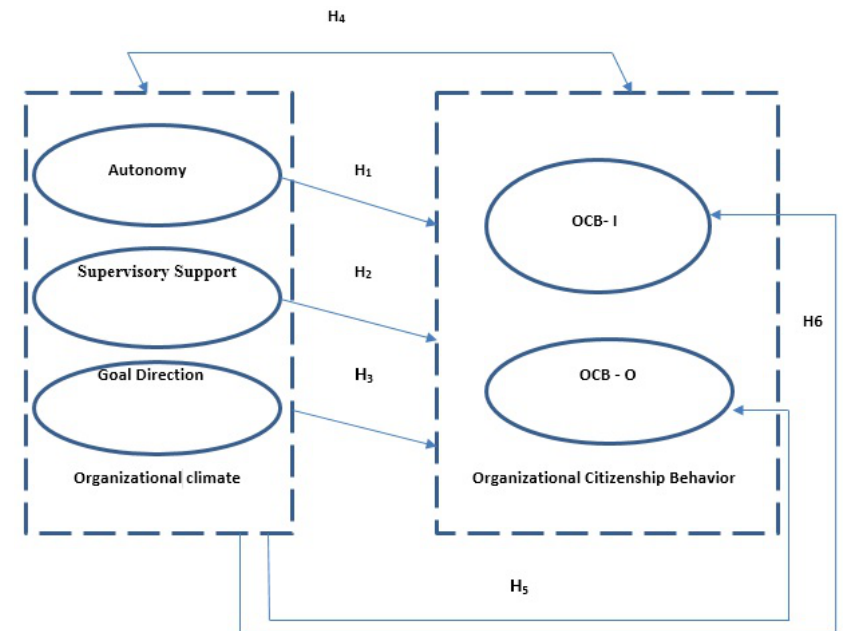
Fig. 1. Conceptual framework: Linking the relationship between organizational climates and organizational citizenship behavior of the non-supervisory staff in the Bank Simpanan National, Malaysia